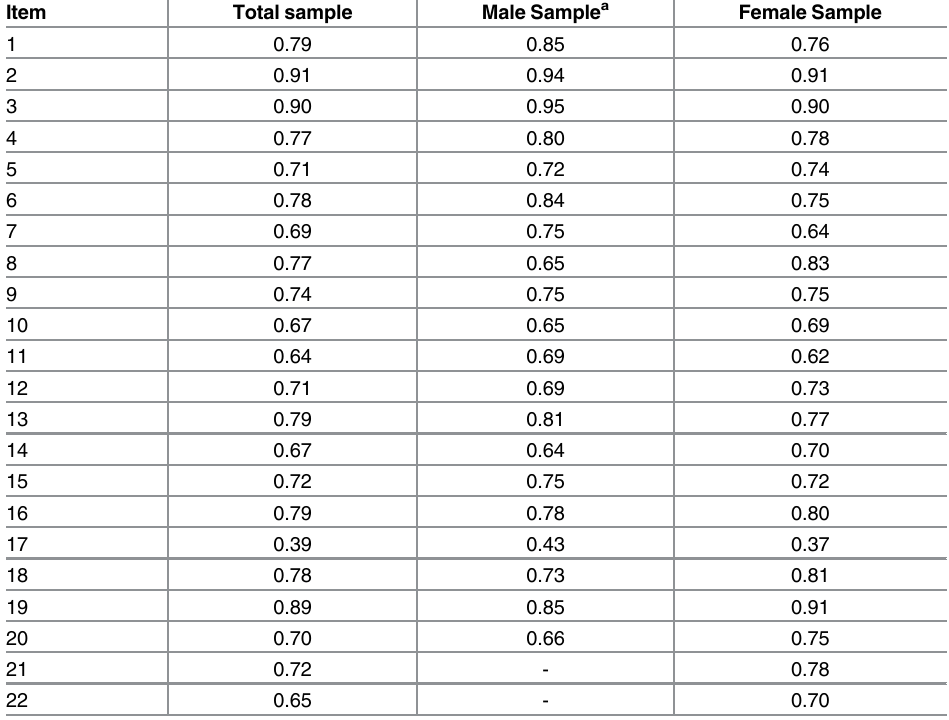
Table 3. Factor loadings for the 1 factor solution of the total sample and of the male and female partic- ipants separately.